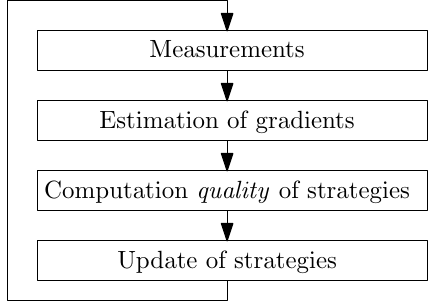
Figure 2. General steps of the heuristic proposed